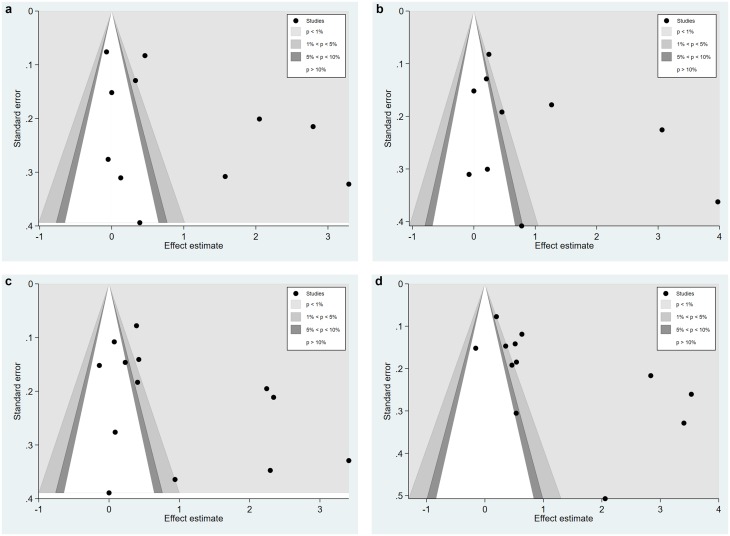
Funnel plots for (a) pain intensity at post-intervention, (b) pain intensity at follow-up, (c) functional disability at post-intervention, and (d) functional disability at follow-up, all control conditions.